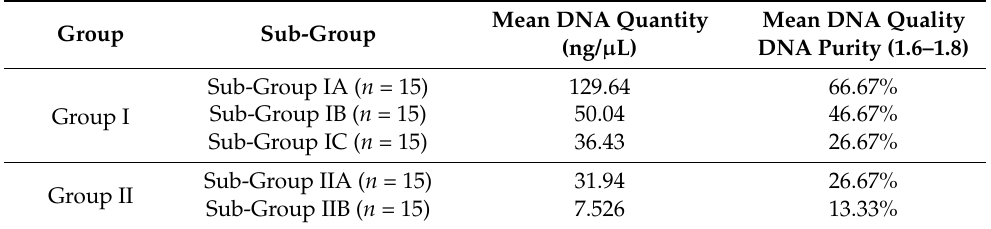
Table 3. DNA quantity and quality obtained across the study